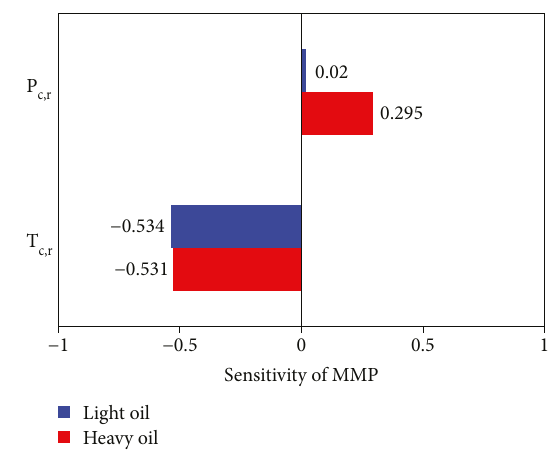
Figure 7: Sensitivity analysis of MMP between injected gas components and crude